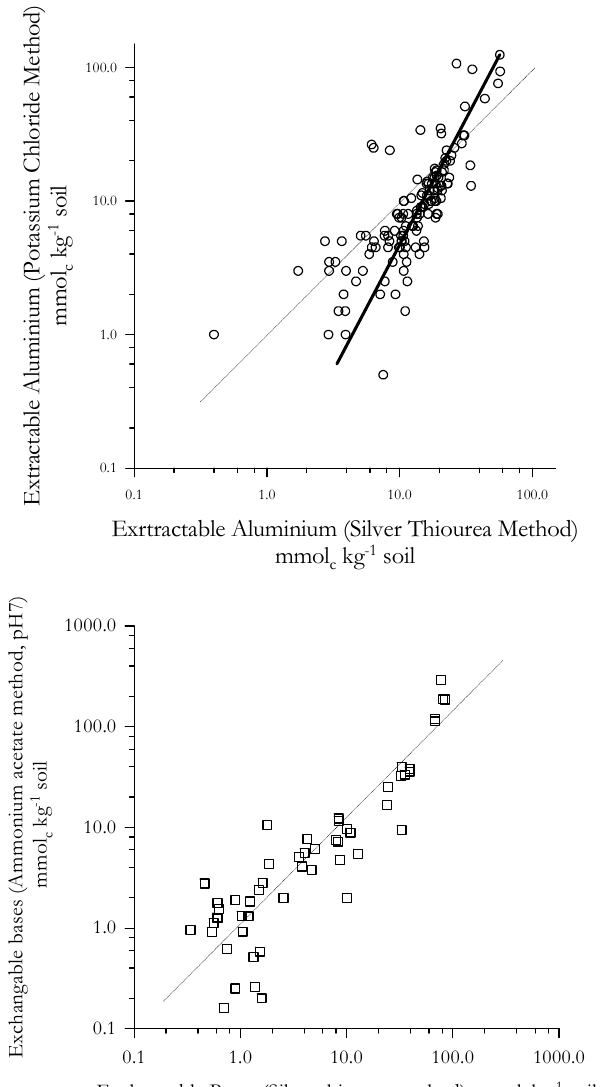
Fig. 2. Cation extraction methods compared: (a) relationship be- Fig. 2 tween KCl versus AgTU extractable aluminium. (b) Exchangeable bases extracted by NH 4 Ac at pH 7 as a function of AgTU exchange- able bases.